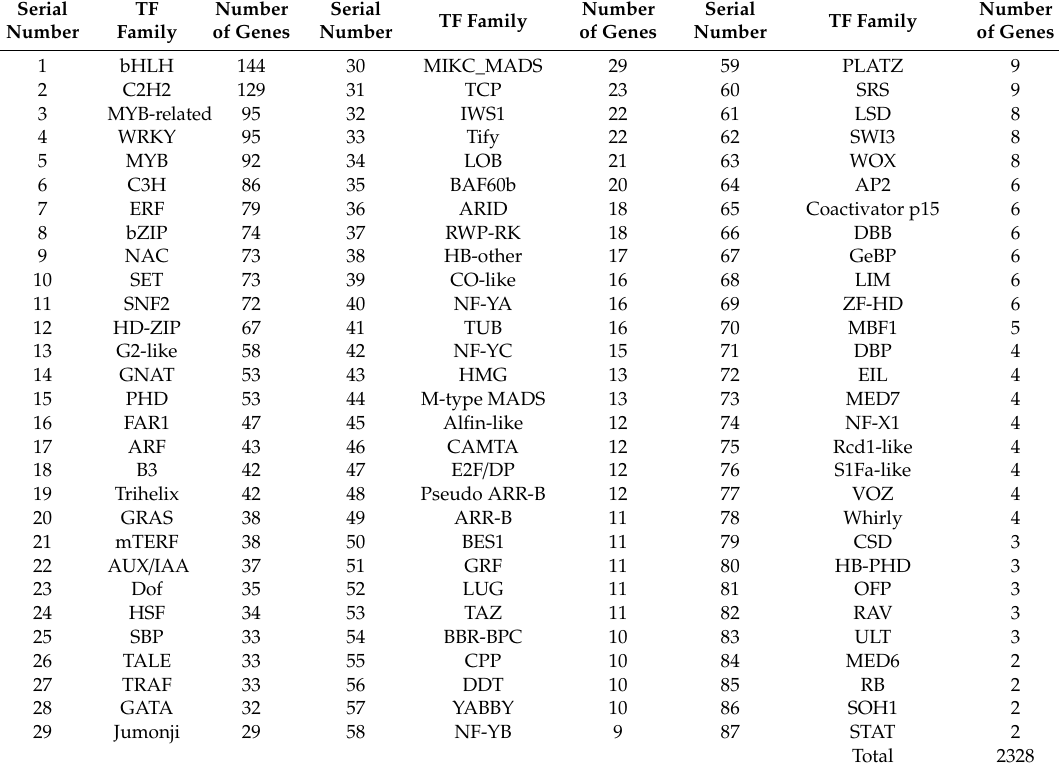
Table 1. List of peanut transcription factor families identified in the transcriptome